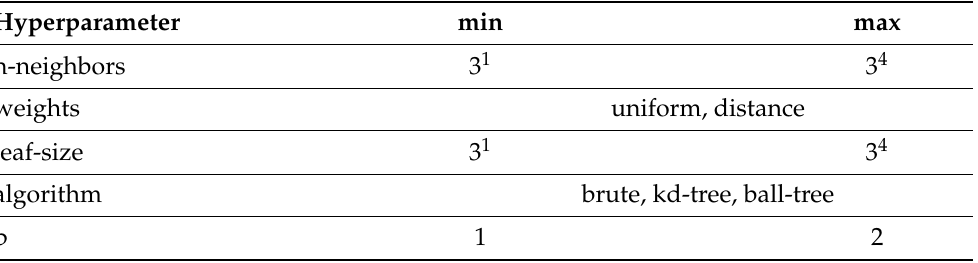
Table 5. Evaluated hyperparameters for the